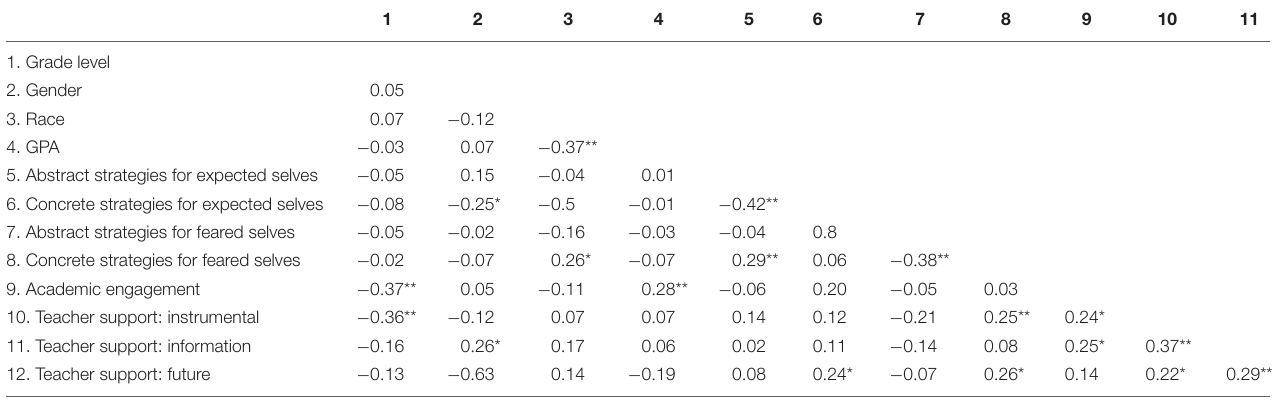
TABLE 4 | Correlations among measured variables ( n =